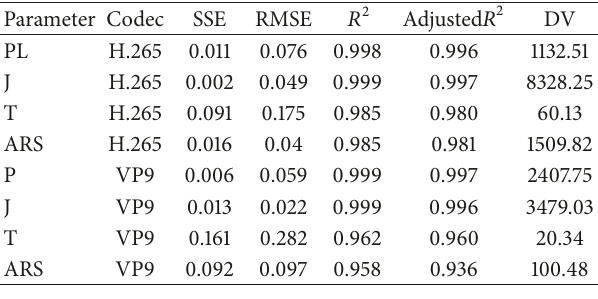
Table 9: Model fitting statistics for network factors.